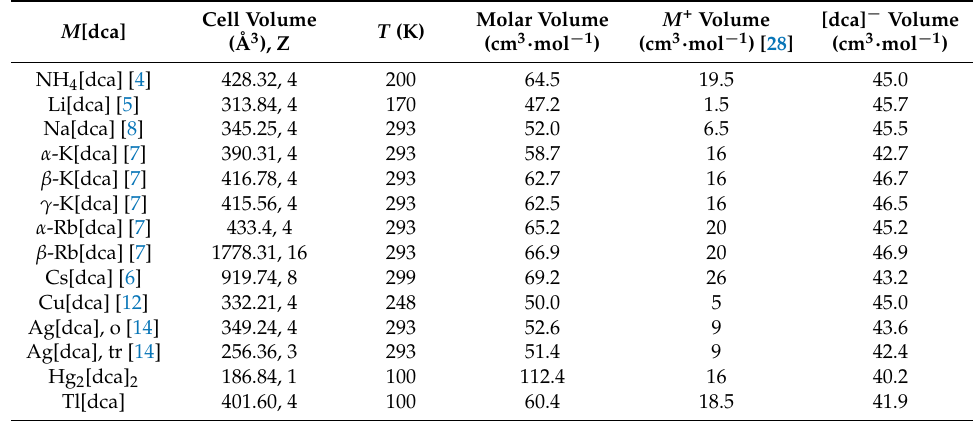
Calculated molar volumes of [dca] − based on M [dca] crystal structures containing monovalent cations.